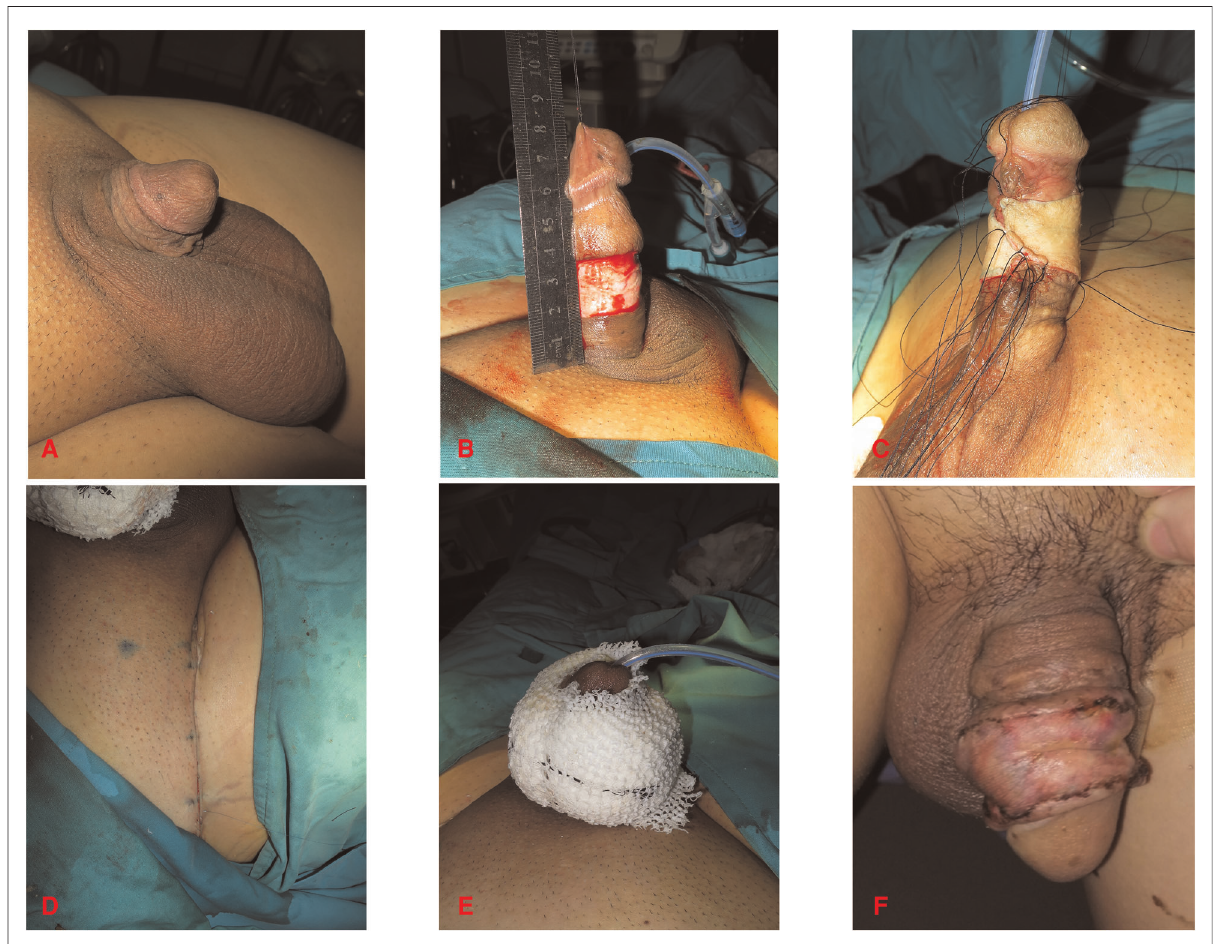
FIGURE 2 42-year-old male. ( A,B ) Preoperative photograph of the penis. ( C ) Incision of the penile skin. ( D,E ) Circumferential full-thickness skin grafting. ( D ) Sutured inguinal area incision. ( E ) Pressure dressing of penis. ( F ) Follow-up at one month after